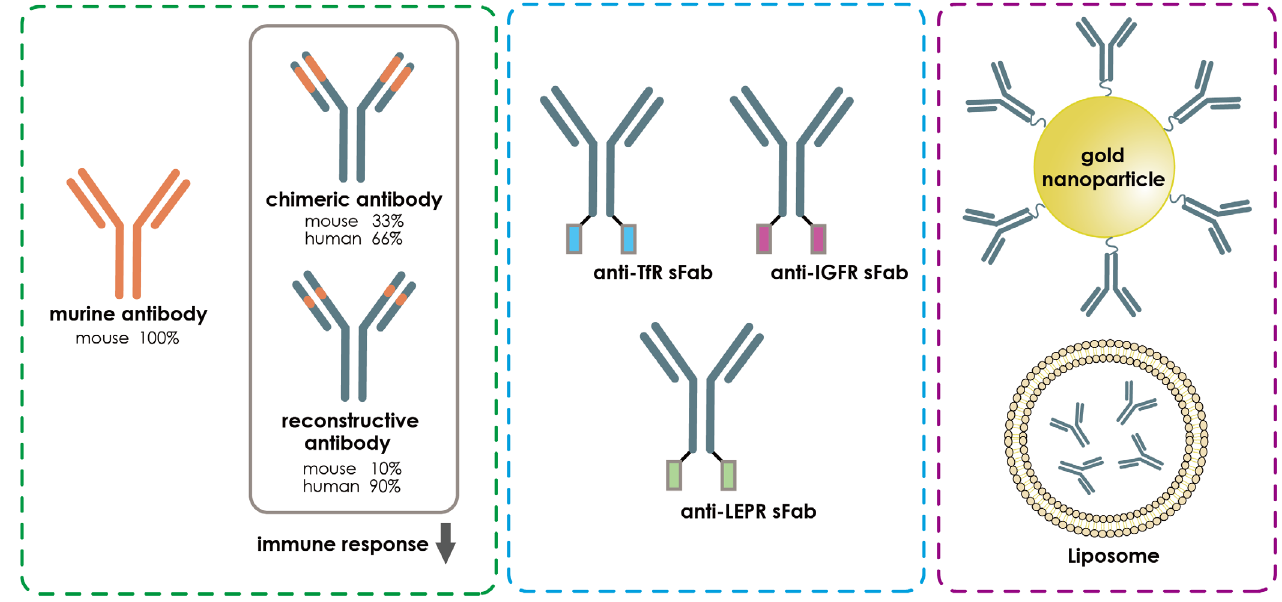
Figure 8. Strategies to improve the efficacy of antibody-based drugs for cerebral ischemia. The over-activation of immunological responses by the antibody drugs could cause serious biological and clinical consequences. The recent development of fully human or humanized antibodies has greatly reduced the risk for inducing exaggerated immune responses compared to the mouse or chimeric antibodies. Meanwhile, bivalent conjugation of an antibody of BBB enriched receptors, such as TfR, LDLRP, or NACR, with the target antibody drug could significantly increase the efficacy of receptor-mediated transport of antibodies into the brain. Nanoparticles or liposomes, which prevent the degradation of antibody drugs and show better efficacy in BBB penetration, can be used as vehicles to transport the antibody into the brain after cerebral ischemia.